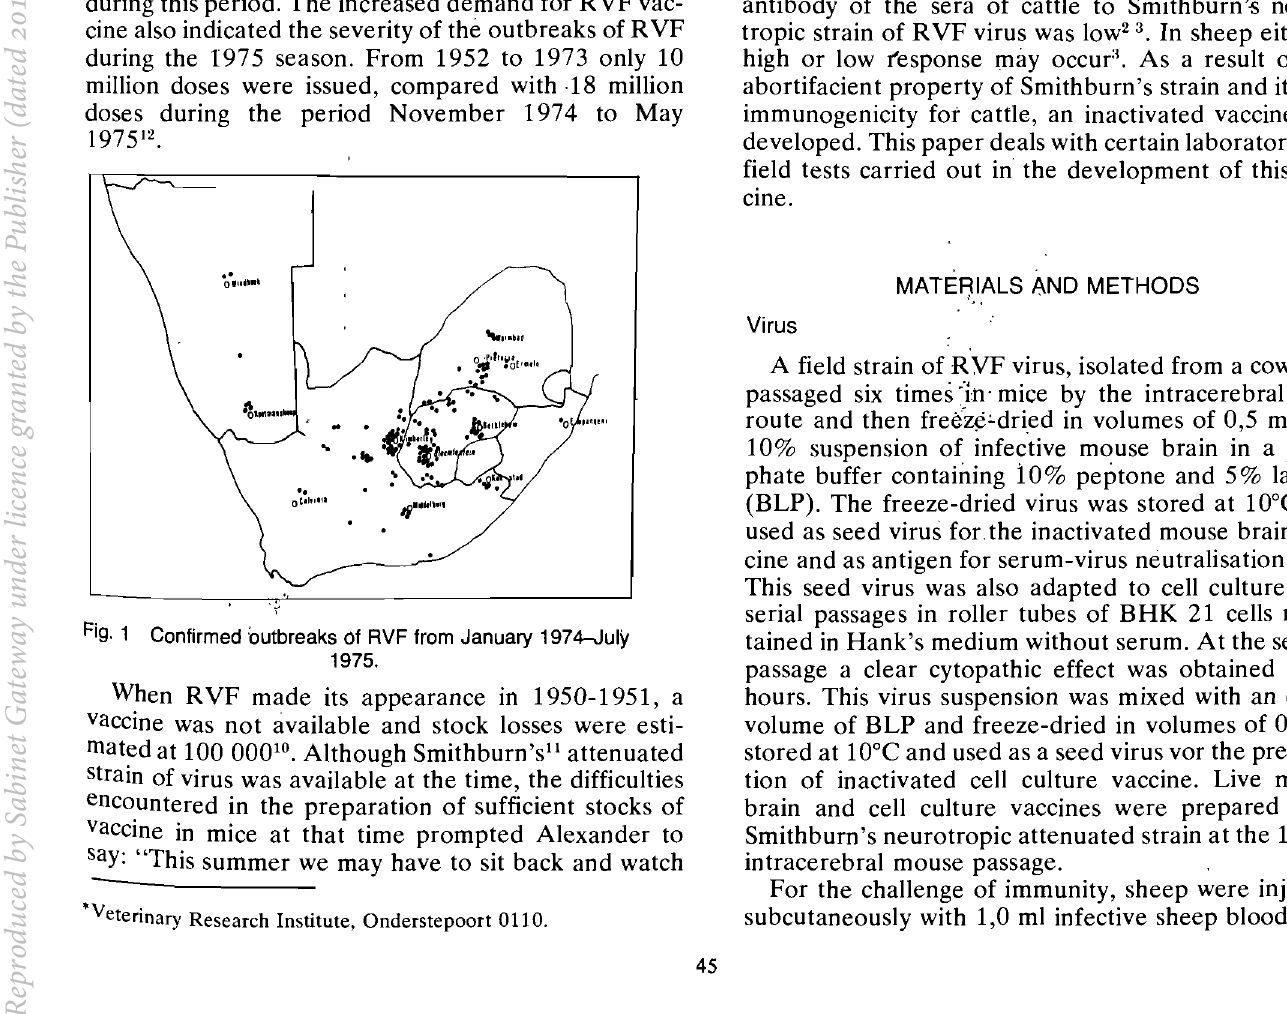
Fig. 1 Confirmed 'outbreaks of RVF from January 1974-July